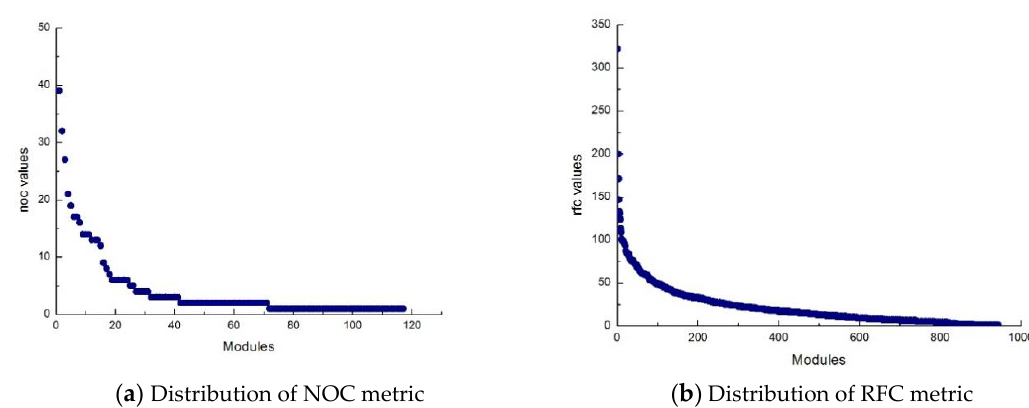
Figure 1. Distributions of metrics values of number of children of a given class in an inheritance tree (NOC) and number of distinct methods invoked by code in a given class (RFC) in the Camel1.6